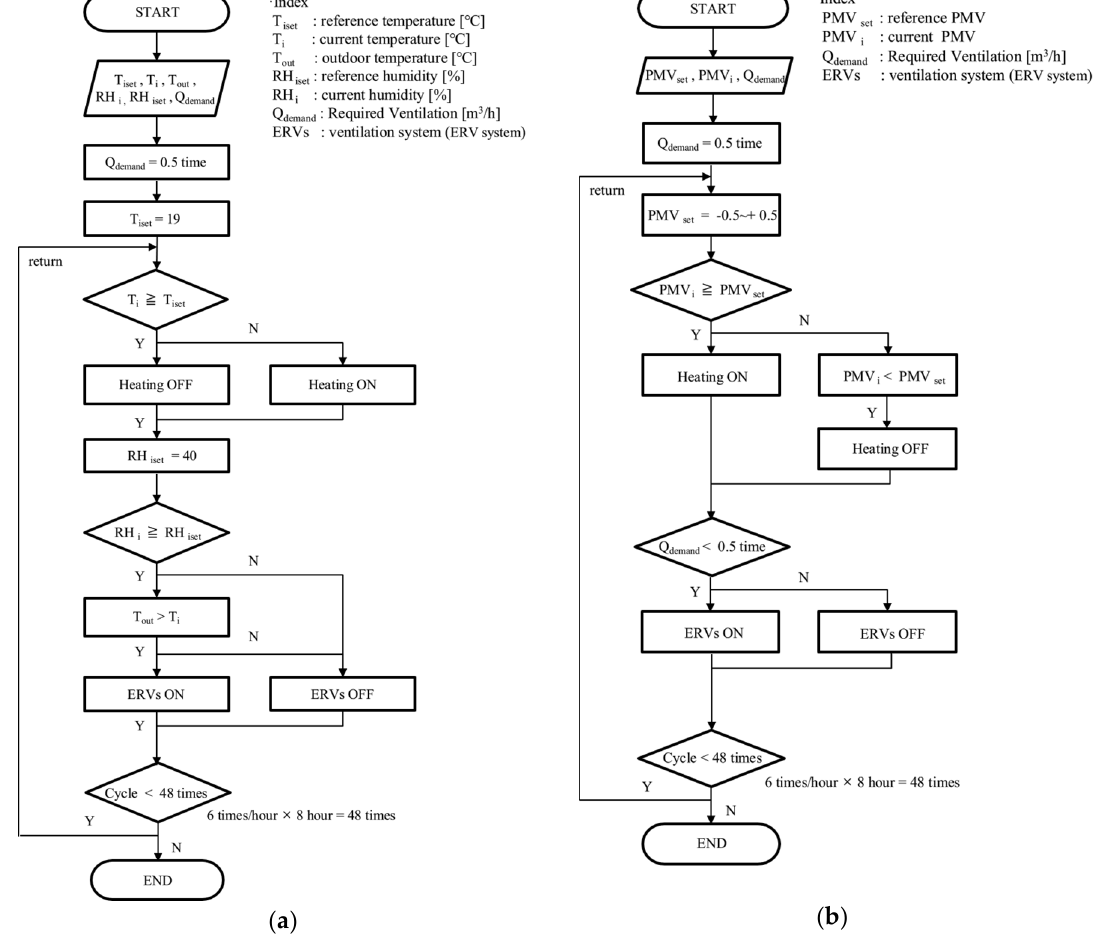
Figure 1. Control algorithm: ( a ) control algorithm for the experimental group A; ( b ) control algorithm for experimental group B.